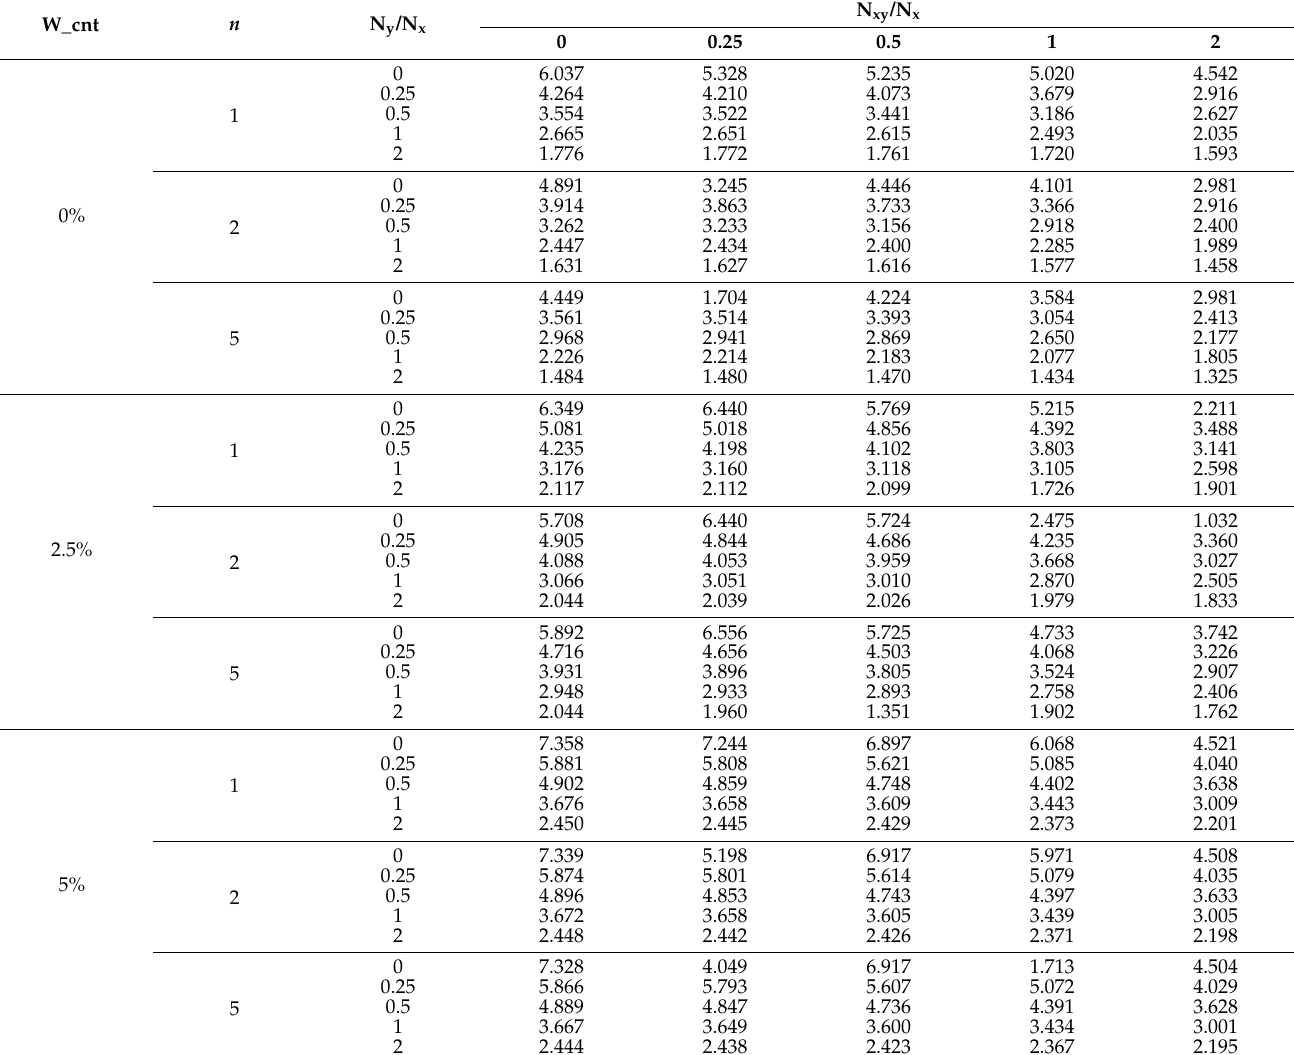
Table 10. Non-dimensional biaxial and shear buckling load for the simply supported